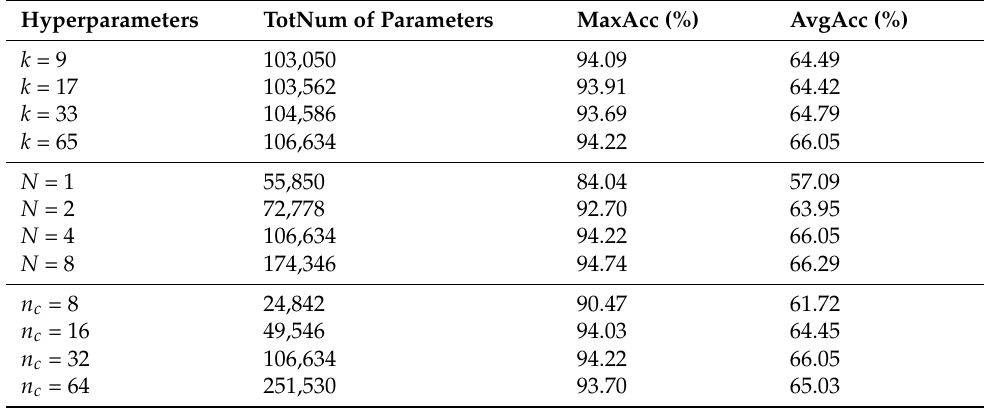
Table 5. Comparison of different network